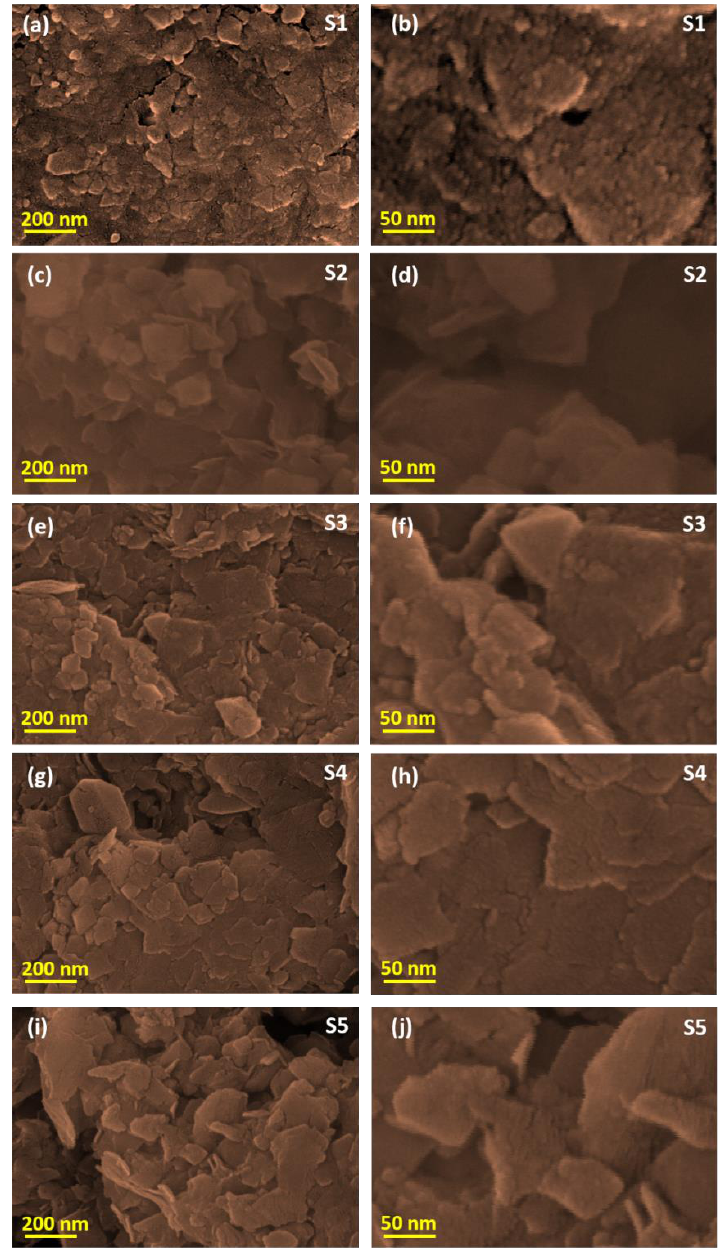
Figure 2. SEM micrographs of composites ( a , b ) S1, ( c , d ) S2, ( e , f ) S3, ( g , h ) S4, and ( i , j ) S5.